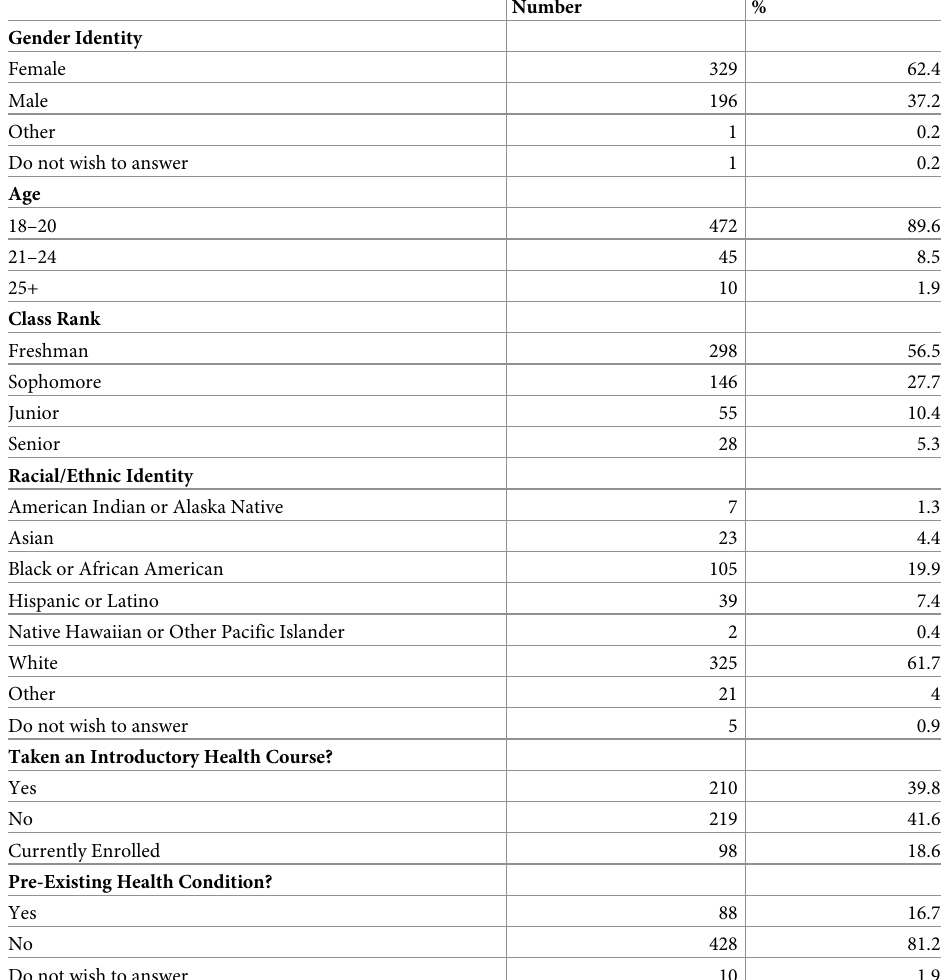
Table 1. Demographic characteristics of survey participants (N =